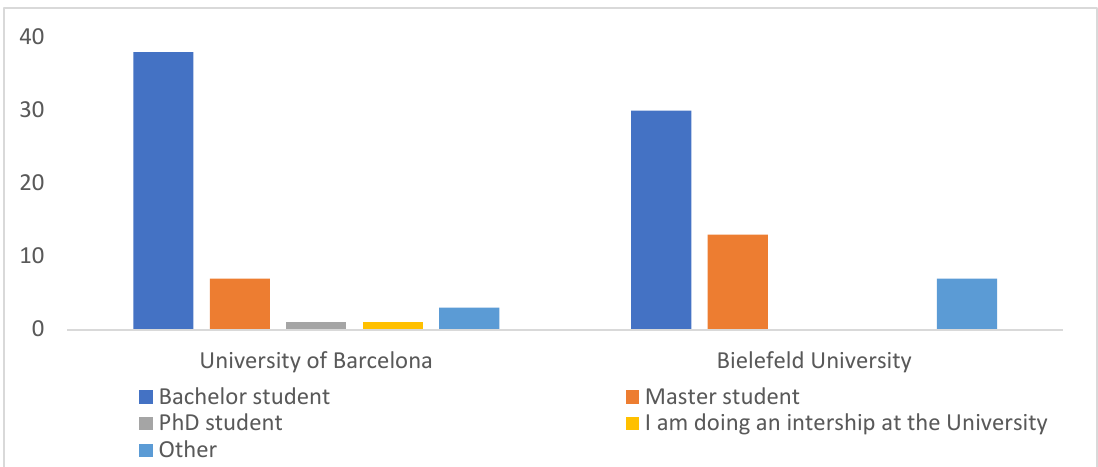
Figure 9. Redistribution of respondents in terms of level of education.